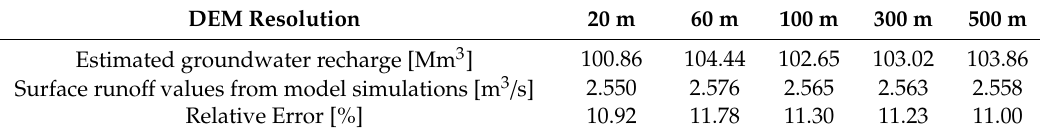
Results of the application of the inverse hydrogeological balance to the case study—evapotranspiration calculated with the modified Turc formula for Sicilian’s catchments.